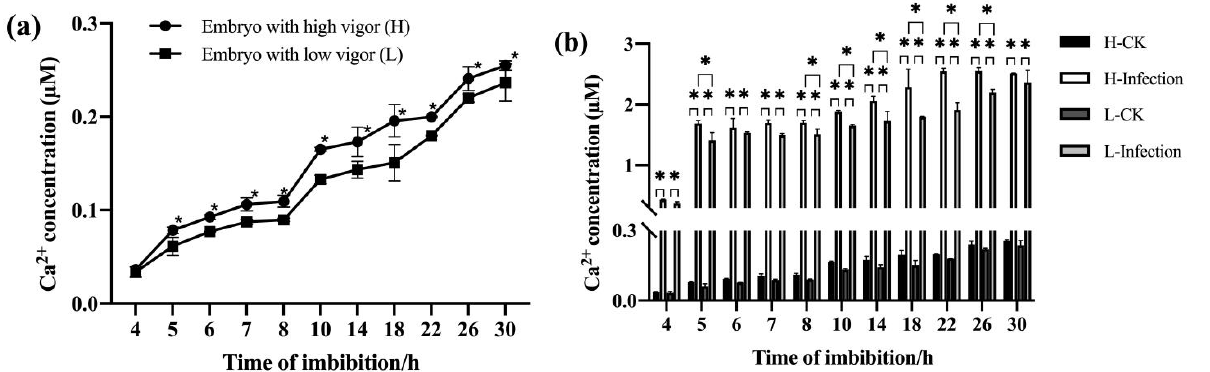
Figure 4. Ca 2+ concentration in the cytoplasm and nucleus of embryo cells during imbibition of maize seeds with different vigor levels. ( a ) Ca 2+ concentration without F. graminearum infection, ( b ) Ca 2+ concentration before and after F. graminearum infection. * indicates p < 0.05 (Student’s t -test), and ns represents not significant.